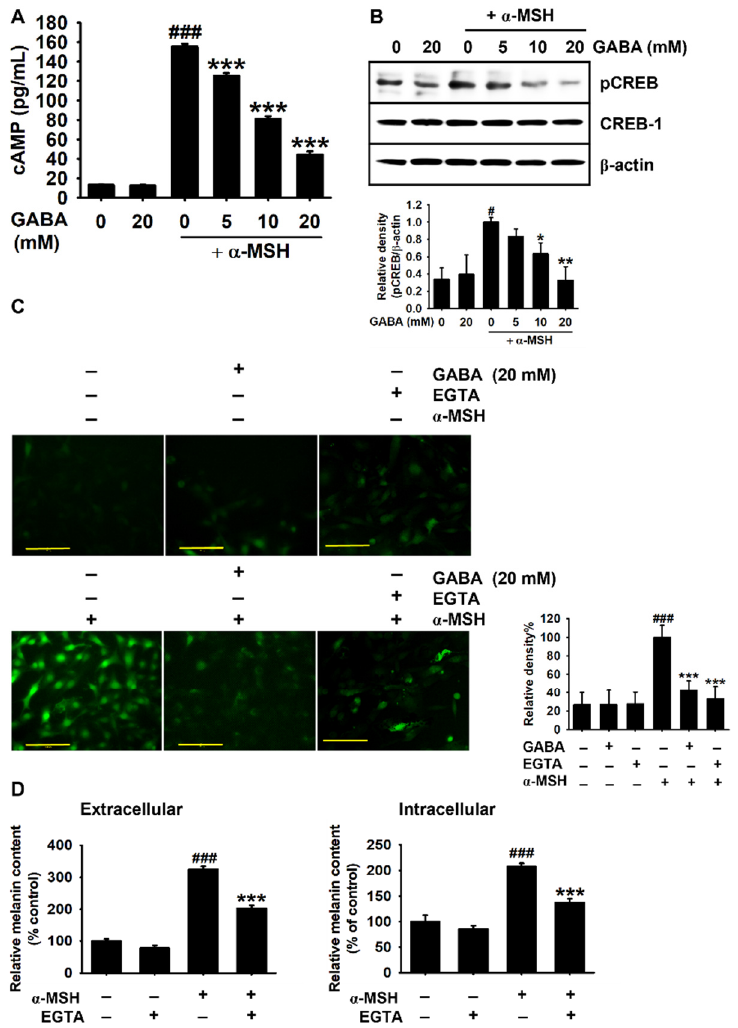
Figure 4. GABA inhibits melanogenesis by downregulating cAMP–CREB-dependent intracellular Ca 2+ . B16F10 melanoma cells (5 × 10 4 cells/mL) were treated with the indicated concentrations of GABA (0–20 mM) in the presence and absence of 500 ng/mL α -MSH. ( A ) cAMP levels were measured using an ELISA kit 15 min after treatment with GABA (0–20 mM) in the presence and absence of 500 ng/mL α -MSH. ( B ) Total CREB and phosphorylated CREB (pCREB) were evaluated by Western blotting 30 min after GABA treatment. ( C ) The cells were grown in 8-well chamber slides and treated with GABA or 2 mM EGTA in the presence and absence of 500 ng/mL α -MSH for 1 h. The cells were probed with 1 µM Fluo-4 AM for 10 min. Cell images were captured by a CELENA S Digital Imaging System (20×). Scale bars = 100 µm. ( D ) Antimelanogenic effect of EGTA was evaluated by measuring extracellular (left) and intracellular (right) melanin contents. The results represent the average of data obtained from three independent experiments and are expressed as the mean ± standard error of the mean (SEM) ( ### p < 0.001 and # p < 0.05 vs. untreated cells; *** p < 0.001, ** p < 0.01, and * p < 0.05 vs. α -MSH-treated cells). GABA, gamma-aminobutyric acid; α -MSH, α -melanocyte-stimulating hormone; cAMP, cyclic adenosine monophosphate (cAMP), CREB, cAMP response element-binding protein; EGTA, ethylene glycol-bis(2-aminoethylether)- N,N.N ʹ ,N ʹ -tetraacetic acid.